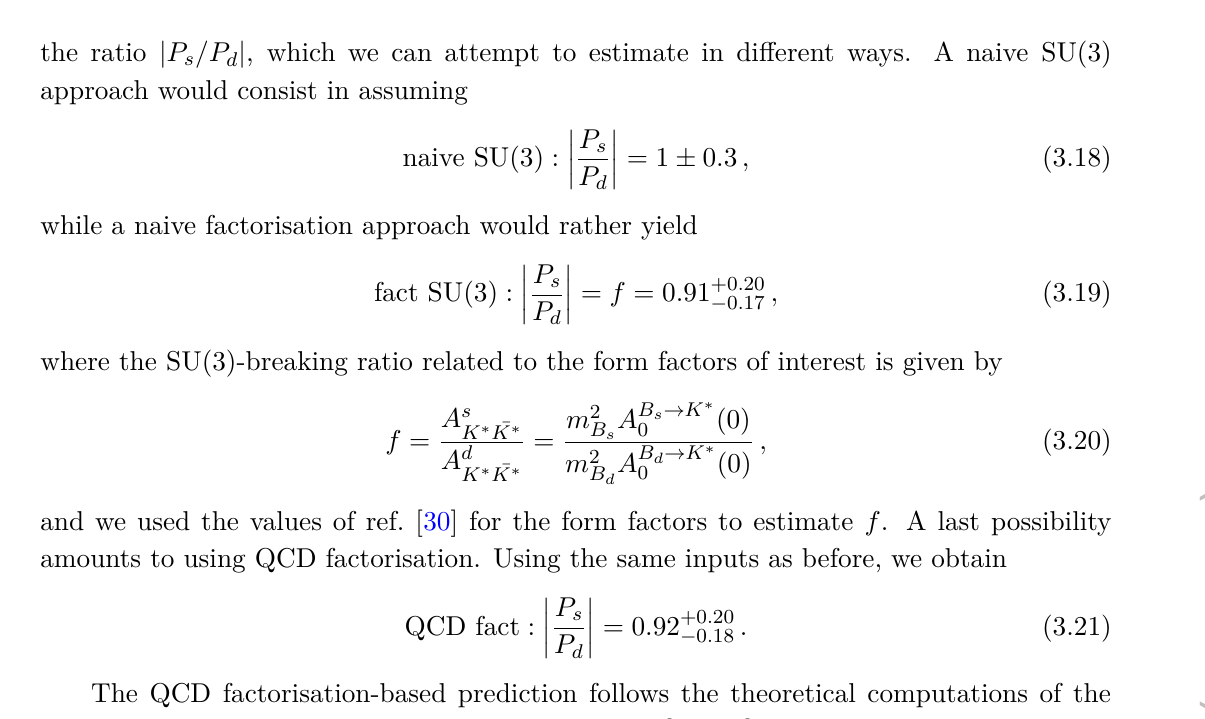
within QCD factorisation. K ∗ ¯ K ∗